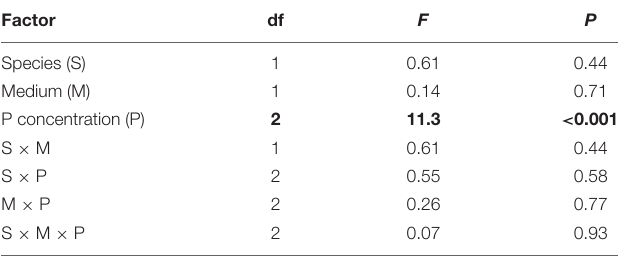
TABLE 2 | Results of three-way ANOVA testing the effects of species ( C. elongata vs. C. silvae-gabretae ), media (inorganic vs. organic), and three P concentrations on cell volume.